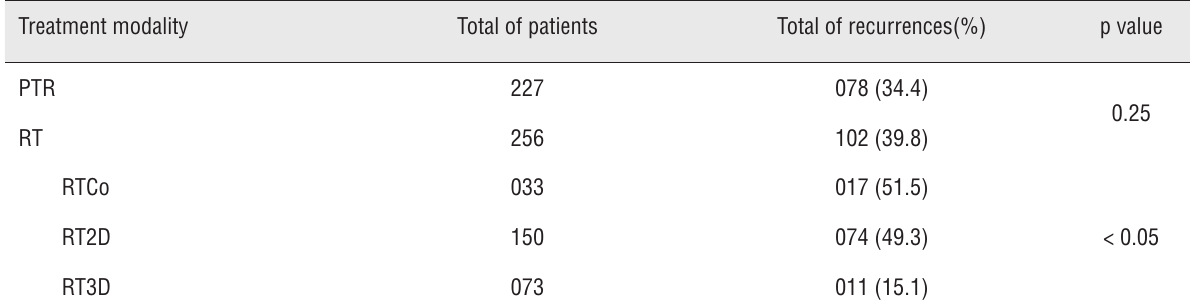
Table 3 - Pre-treatment risk factors and biochemical